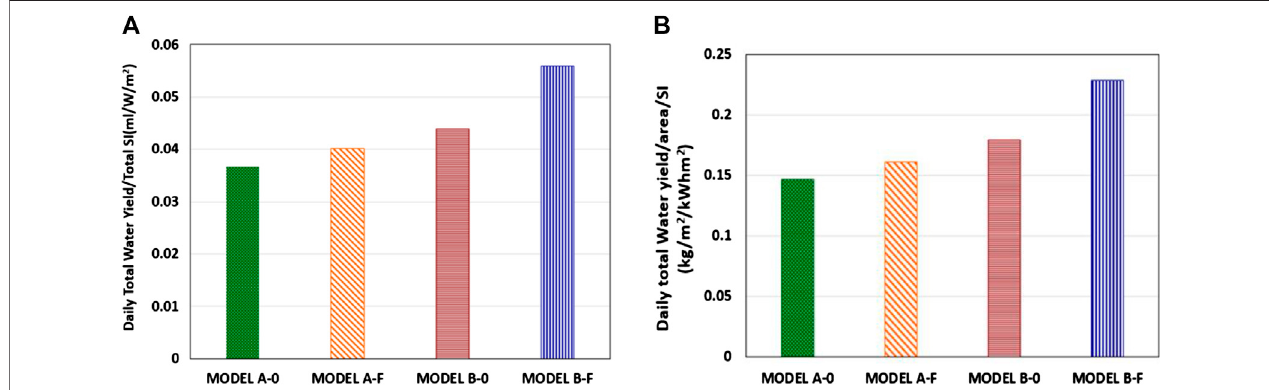
FIGURE 5 | ( A ) The total water yield over total SI. ( B ) The total water yield per unit area over total SI.